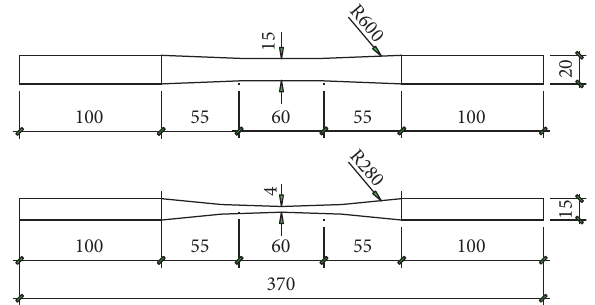
Figure 1: Size of tensile specimen parallel to the